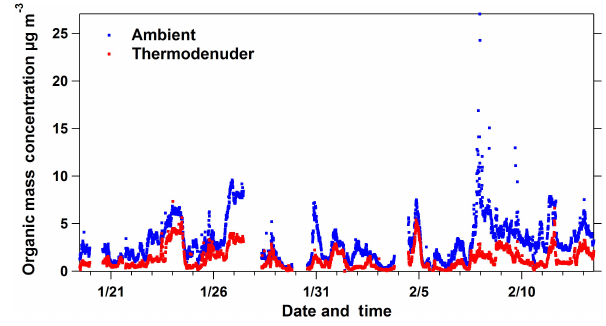
Figure 1. Ambient (blue dots) and thermodenuder (red dots) or- ganic mass concentration measurements for Paris during summer 2009.